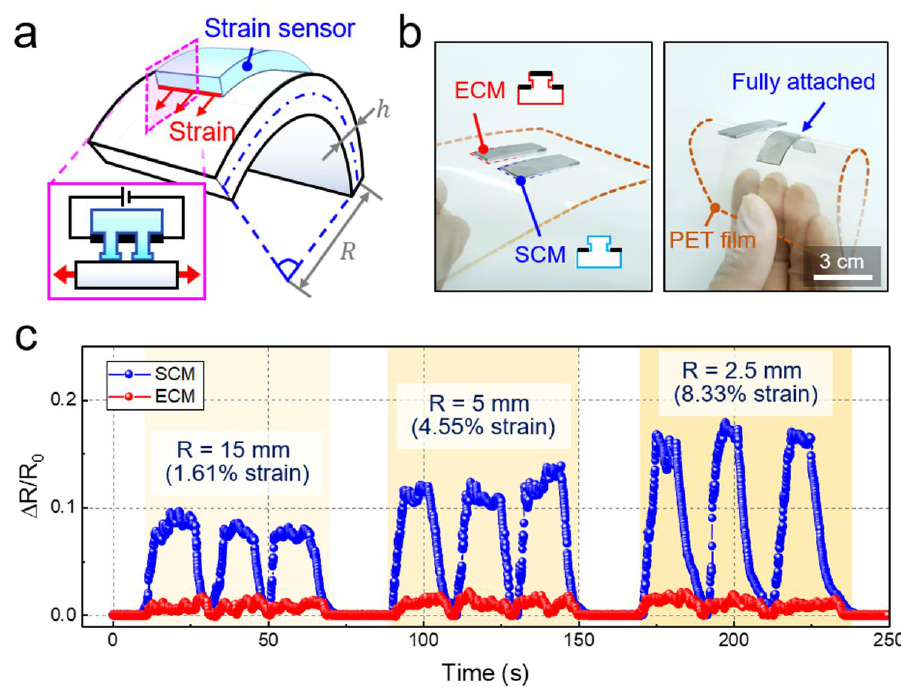
Figure 4. Comparison of the sensing performances of the self-attachable and non-attachable strain sensors. ( a ) Schematic illustration showing the working principle of the self-attachable strain sensor under bending stress. ( b ) Photographs showing the adhesion and bending behavior of the entirely MWCNT-coated micropillar (ECM) and selectively MWCNT-coated micropillar (SCM) strain sensors attached on a PET film under bending. ( c ) Time-resolved changes in the relative resistance measured by the ECM and SCM sensors for different bending radii (15, 5, and 2.5 mm).